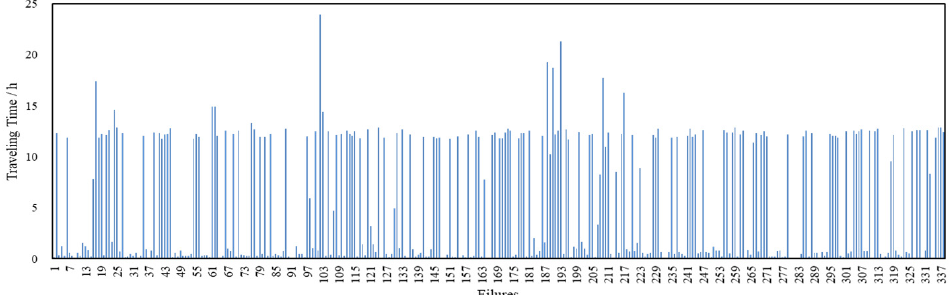
Figure 11. Travelling times of maintenance to the 338 failures.